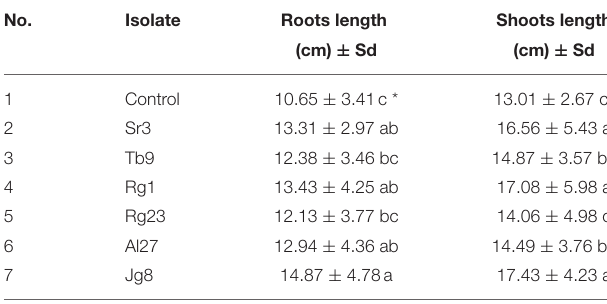
TABLE 2 | Effect of rhizobacteria to the length of roots and shoots of corn cultivar Pertiwi at the age of 7